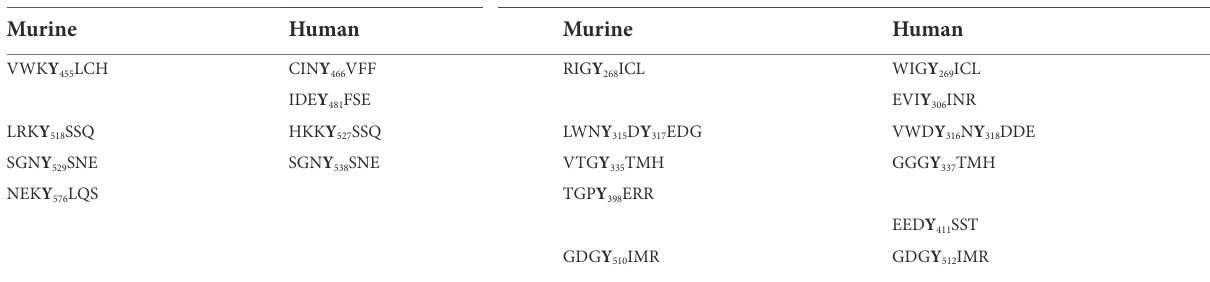
TABLE 1 Overview about amino acid surrounding tyrosine